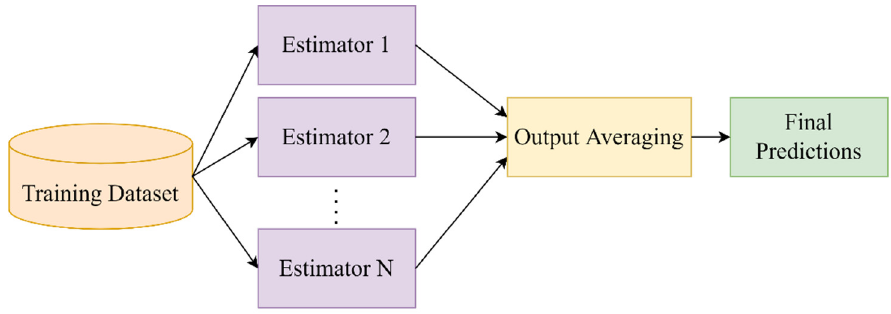
Figure 2. Voting regressor structure for the averaging of 𝑁 estimators.